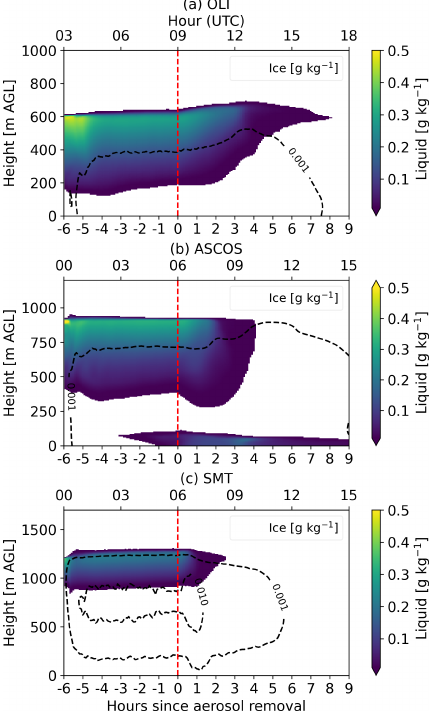
Figure 5. Contours for cloud water (color shading) and ice (dashed) (a) OLI, (b) ASCOS, and (c) SMT simulations. Ice is contoured at 0.01 and 0.001gkg − 1 (the 0.01gkg − 1 contour is only present in c ).